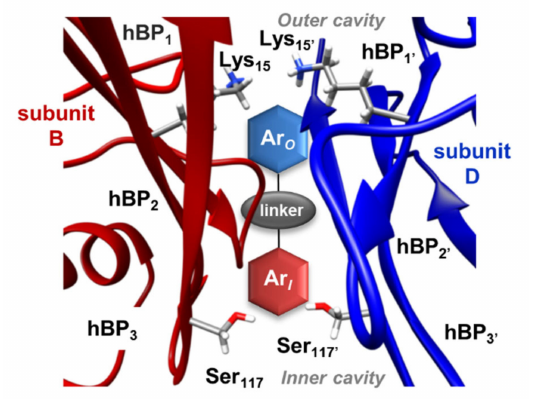
Figure 3. Expanded schematic view of one of the two T 4 binding pockets (dimer BD), where hBP 1 is located between the side chains of Lys 15 / 15’ , Leu 17 / 17’ , Thr 106 / 106’ and Val 121 / 121’ , hBP 2 between the side chains of Leu 17 / 17’ , Ala 108 / 108’ , Ala 109 / 109’ and Leu 110 / 110’ and hBP 3 between the side chains of Ser 117 / 117’ , Thr 119 / 119’ , Ala 108 / 108’ and Leu 110 / 110’